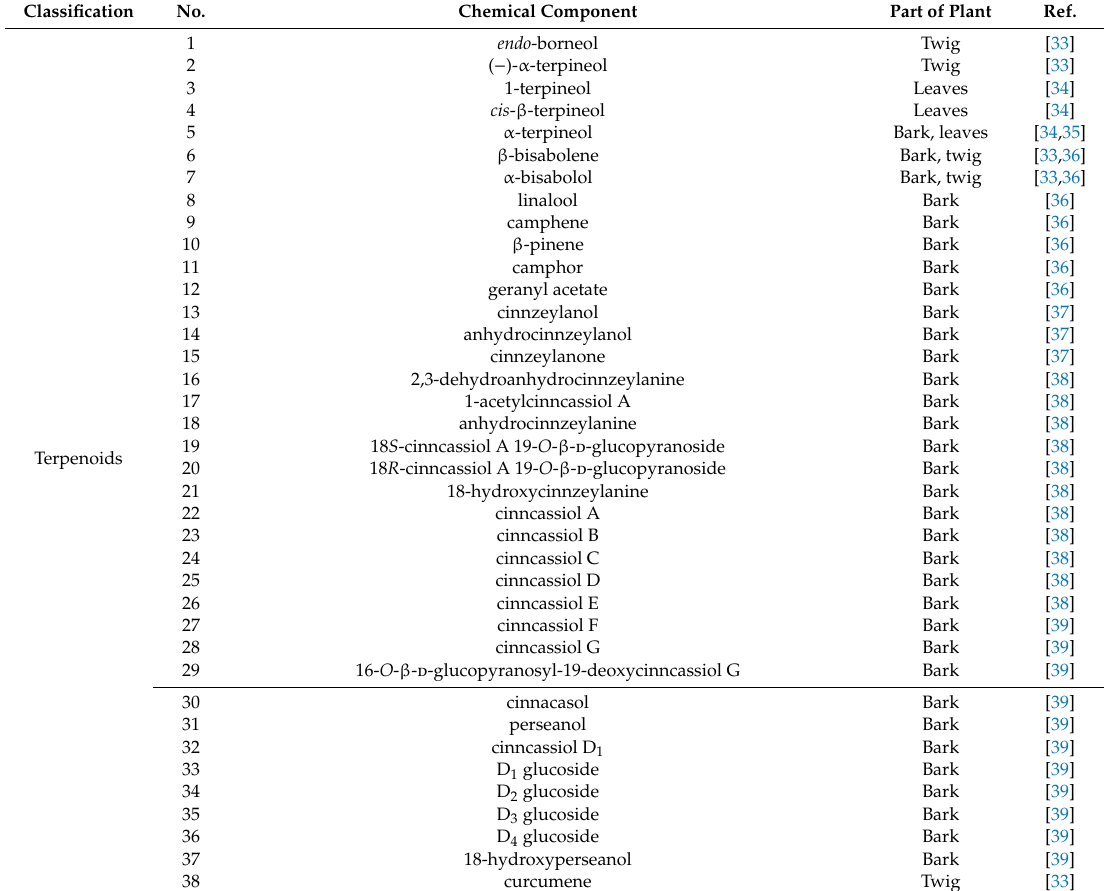
Table 2. Chemical constituents isolated from C. cassia